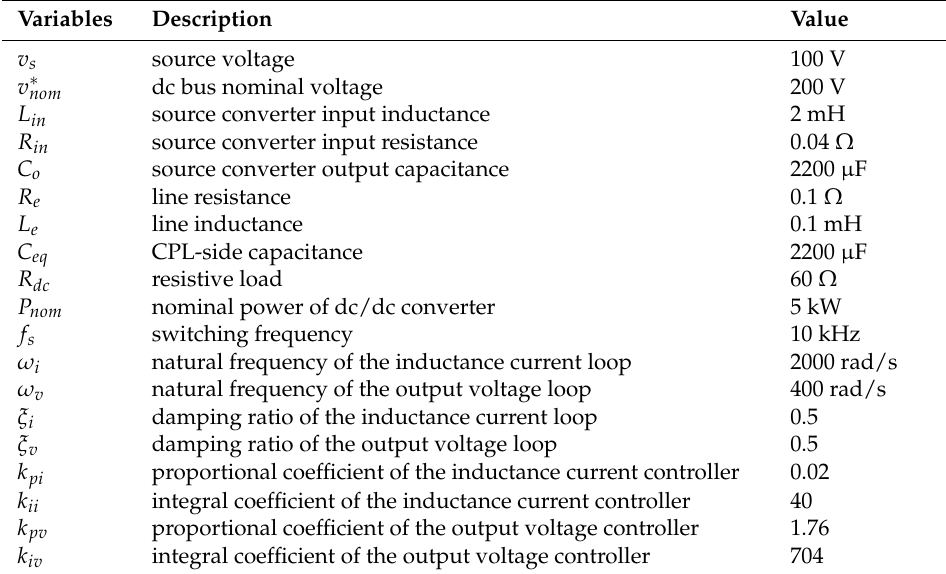
Table 1. The parameter values for the studied dc microgrid